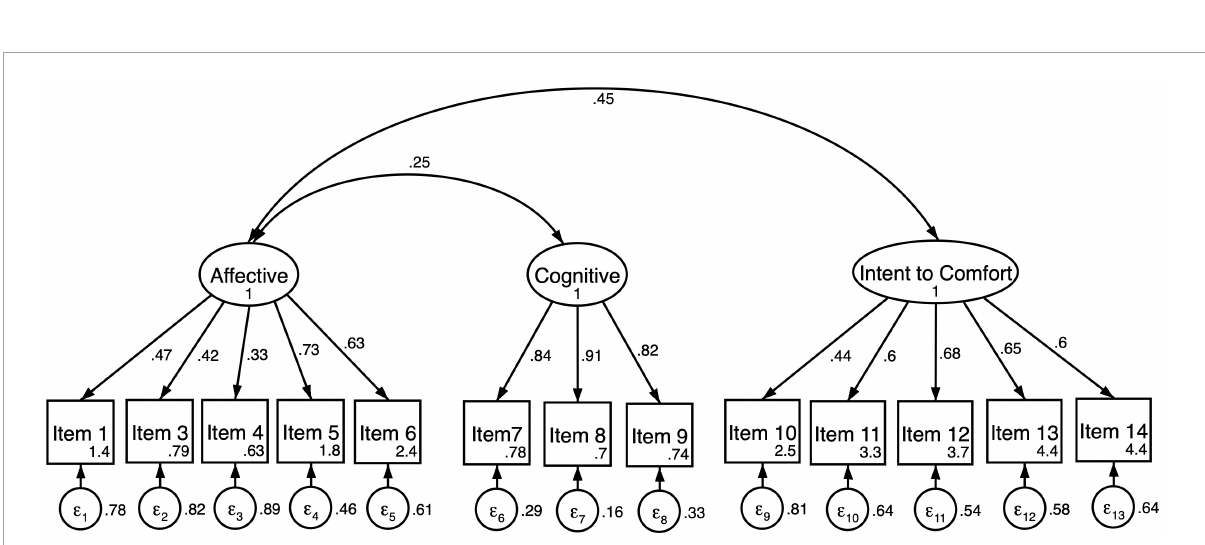
FIGURE3 Revised three-factor confirmatory factory analysis of the EmQue-CA (13 items) for girls ( N = 162). All factor loadings on latent factors significant at the p < 0.001 level. Values inside item boxes represent intercepts. Covariance path from cognitive empathy latent factor to intent to comfort latent factor is removed.